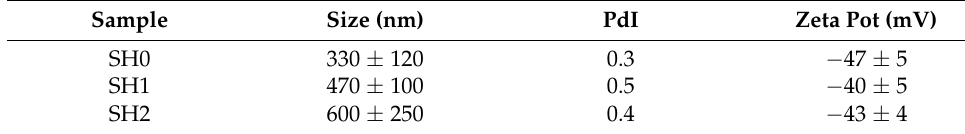
Table 1. Hydrodynamic diameter (size), polydispersity index (PdI), and surface charge (zeta potential) of ZnO-T samples obtained by DLS measurements. The analyses were performed in ultra-pure water (pH 7).